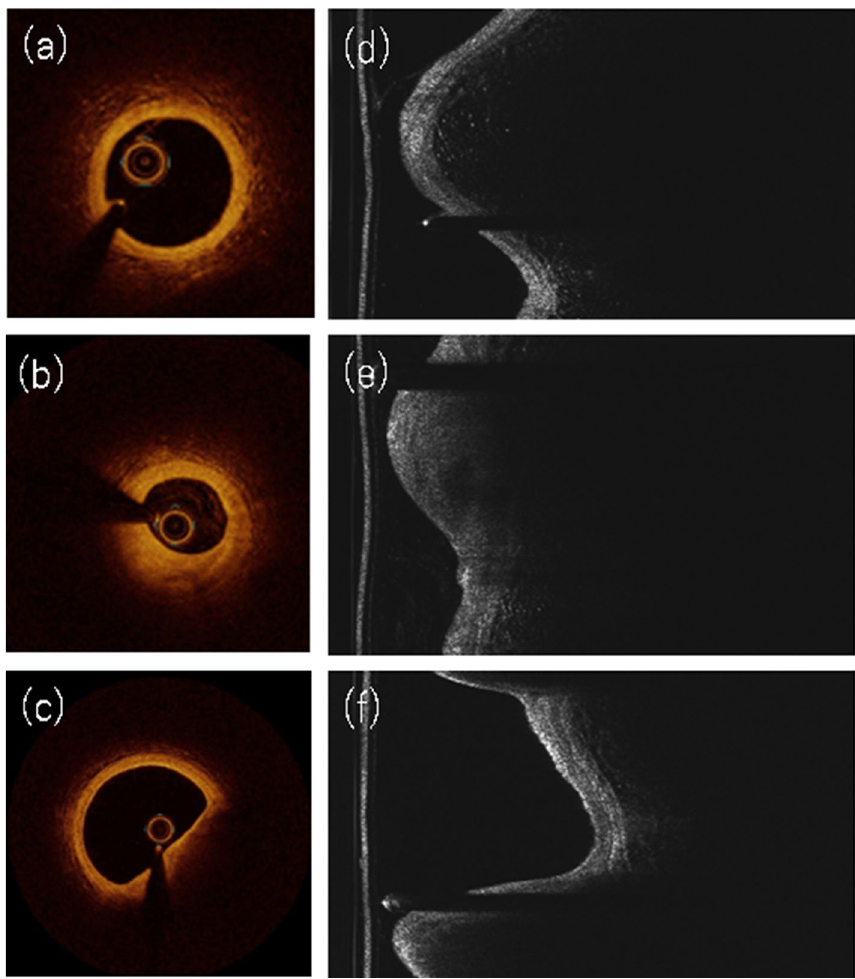
Figure 2. Clinical OCT images and their corresponding raw images. OCT of a normal ( a ), a stable plaque ( b ), and a vulnerable plaque ( c ) diagnosed by OCT expert cardiologists. The clinical OCT images in ( a–c ) were generated from corresponding raw data ( d–f ) by a polar coordinate